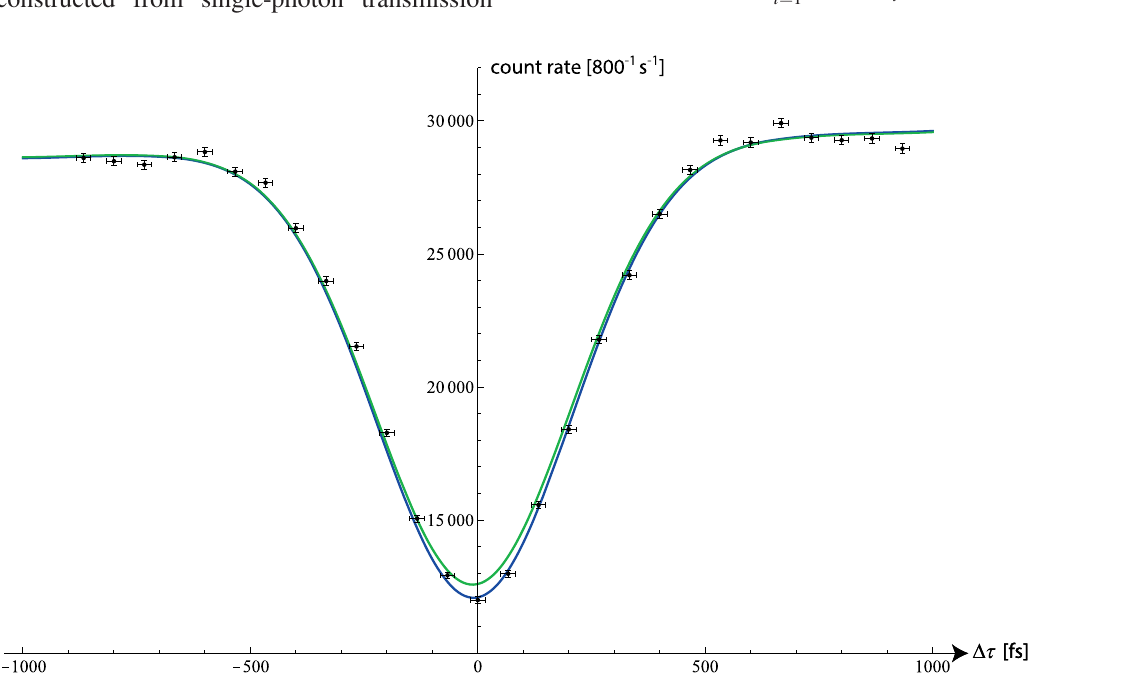
FIG. 8. Example for one data set used for the reconstruction of U 5 . The best fit of Eq. (A27) to the data set is shown in blue. Here, the visibility is calculated from the best fit parameters Y 0 and A . The reduced χ 2 resulting from the fit shown in blue is χ 2 ¼ 2 . 02 . blue Fluctuations in the count rate for values of j Δ τ j > 500 fs drive the reduced χ 2 away from 1. These fluctuations can be interpreted as the random noise background in the lab and the increased reduced χ 2 reflects that. However, the precision of the fitted parameters Y 0 and A and ultimately the extracted visibility V is only marginally affected by these fluctuations. The 5 × 5 unitary description of the interferometric network is reconstructed from 84 of these visibilities. The curve in green, N ð th Þ c ð t Þ [see Eq. (A33)] is calculated from four 2 . 70 . The agreement of these two curves and matrix entries of the reconstructed unitary and results in an overlap with the data of χ 2 green ¼ corresponding reduced χ 2 ’ s is a qualitative measure for the precision of the